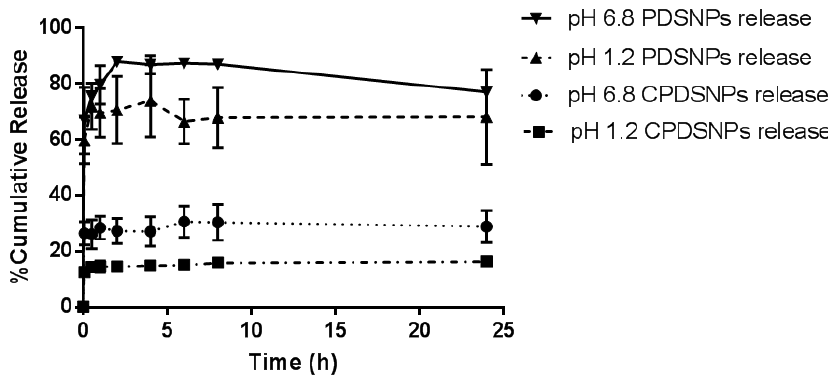
Figure 4. In vitro release profile of exenatide from PDSNPs and CPDSNPs at pH 1.2 and 6.8 for 6 and 8 h, respectively (all data are n = 3, mean ± SD).